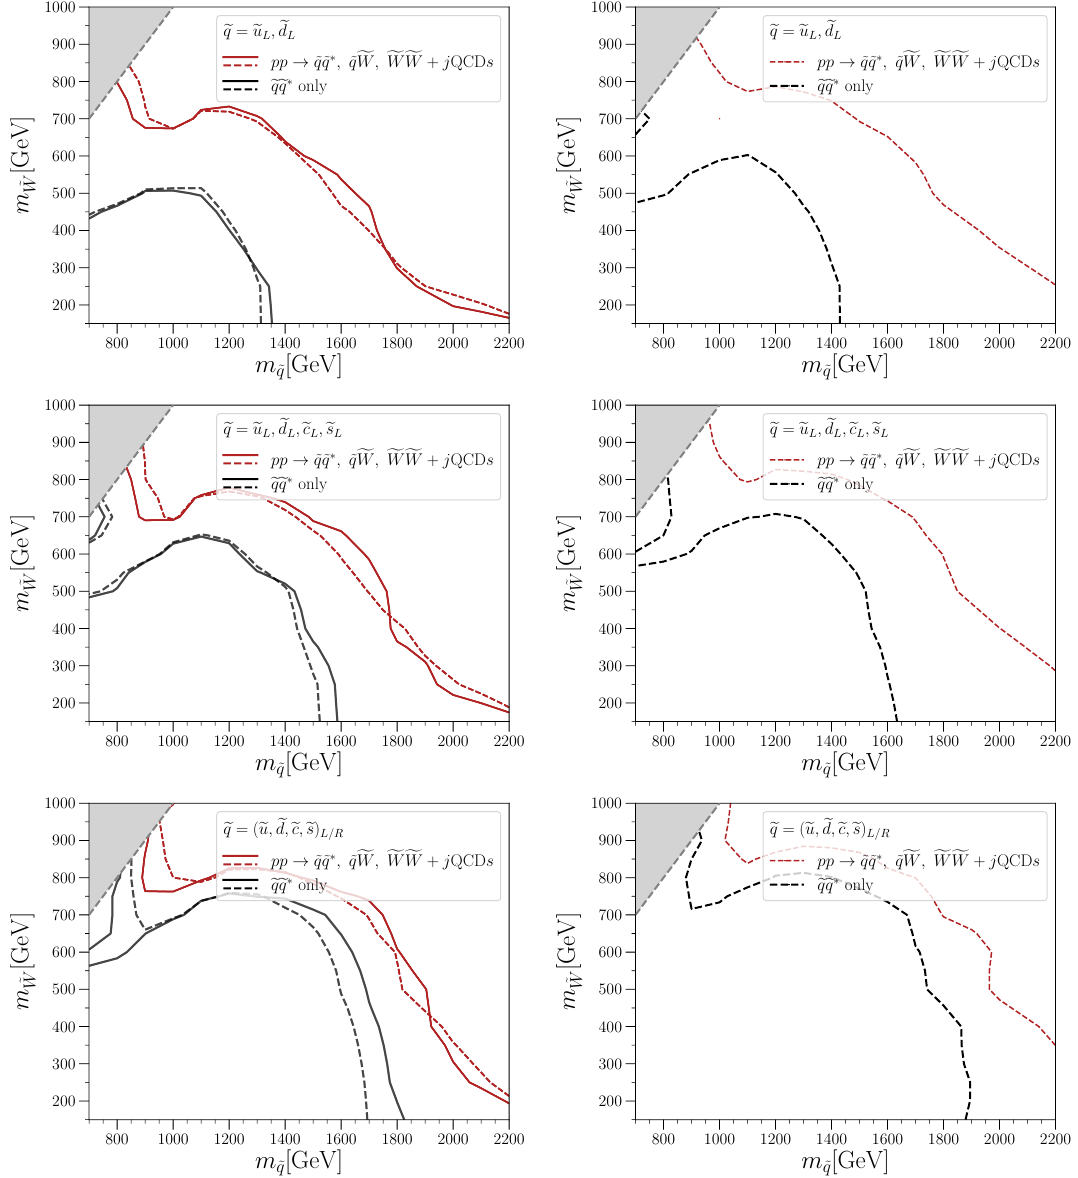
Figure 6 . Left; the 95% CL exclusion limit on the ( m ˜ q , m ) plane obtained by recasting the AT- W LAS “jets + E miss ” analysis [10] with 139 fb − 1 data. The solid curves represent the limit calculated T with the observed data, while the dashed curves correspond to the expected limit assuming the e observed data exactly coincides with the Standard Model expectation. The black curves represent the limit obtained if only the squark pair production is considered, while the red curves correspond W and W W +ISR . The top, middle and to the limit including all production channels: pp ˜ q ˜ q ∗ , ˜ q → bottom panels correspond to the 2, 4 and 8 flavour squark scenarios, respectively. Right; the 95% f f f CL projected sensitivity on the ( m ˜ q , m ) plane obtained by rescaling the ATLAS “jets + E miss ” T W analysis [10] to the Run-3 with 300 fb − 1 (13 e